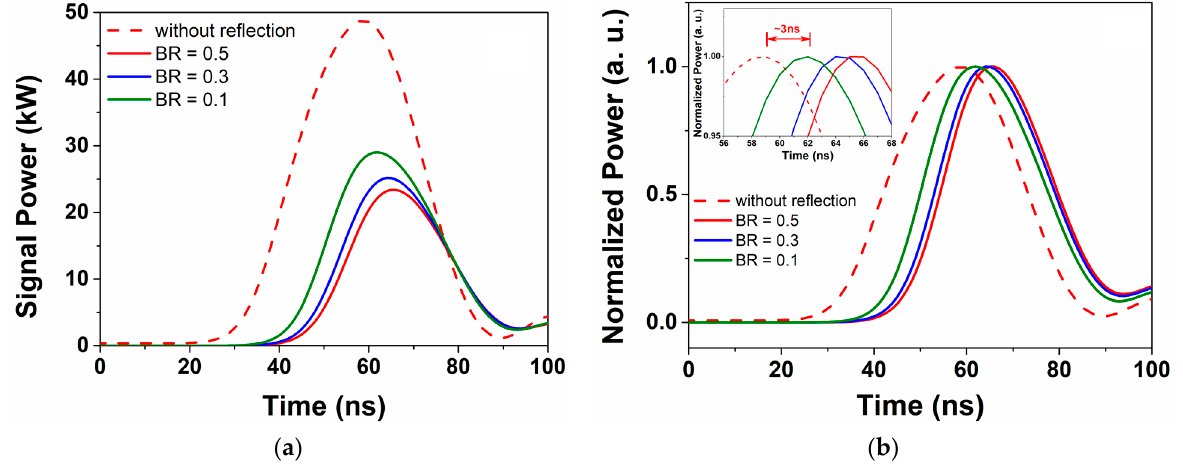
Figure 7. ( a ) The evolutions of the pulse waveforms with di ff erent BR. ( b ) The normalized pulse waveforms with di ff erent BR. The insertion is a magni fi cation of the waveform near the pulse peak.